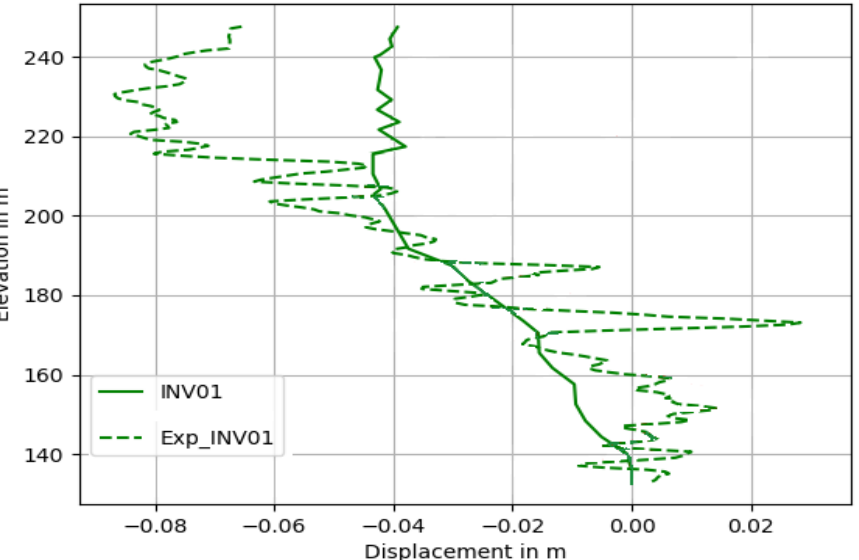
Figure 11. Measurements recorded at INV01 by the inclinometer are denoted by the dotted line. The solid line represents the simulated displacement using the optimal parameter values obtained with DE.